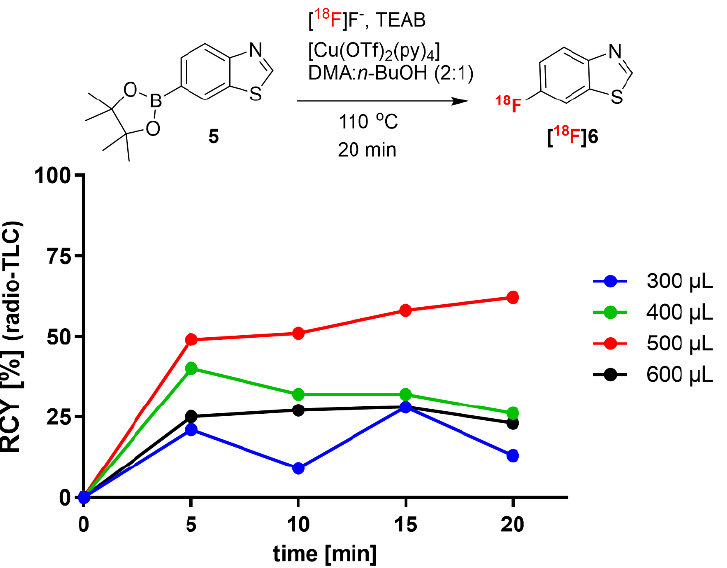
Figure 3. Optimization of radiofluorination on precursor 5 under reduction of the reaction volume.